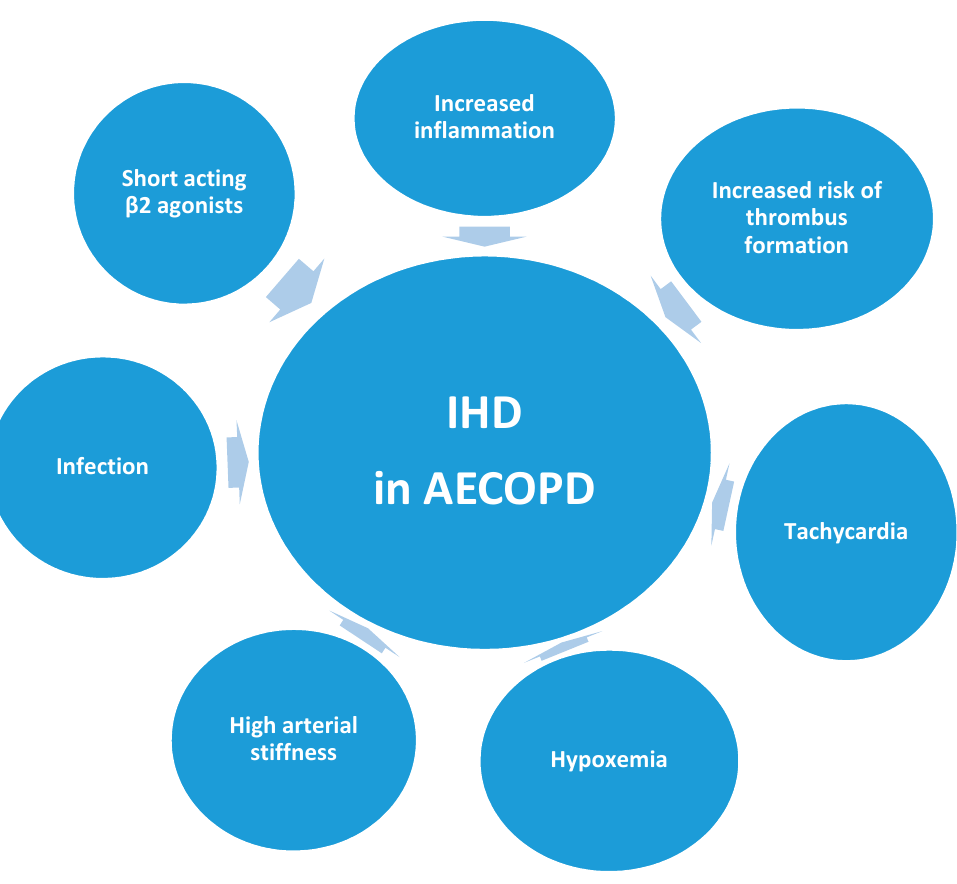
Figure 1. Potential factors contributing to acute ischemic heart disease in exacerbations of COPD. IHD: ischemic heart disease.